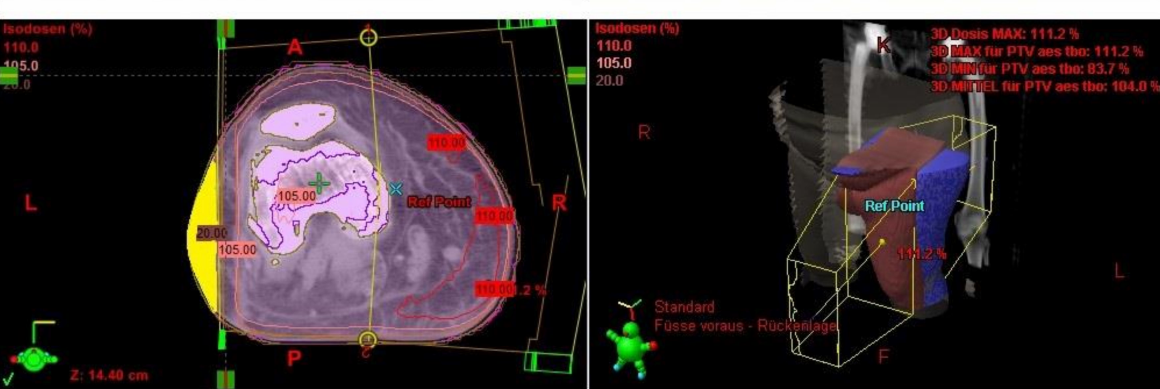
Figure 2. Relatively narrow part of the lymph-sparing volume (yellow) outside the 20% isodose